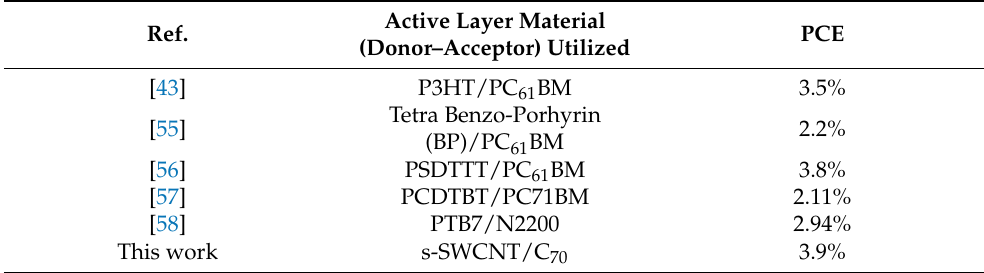
Table 1. Comparison of PHJ experimental work with the present work.